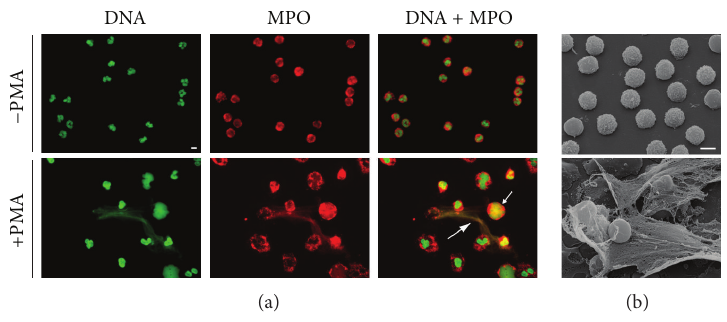
Figure 5: NET formation after PMA stimulation visualized by fluorescence (a) and scanning electron microscopy (b). Upper row shows unstimulated neutrophils; the lower row shows PMA stimulated neutrophils releasing NETs. The scale bar represents 10 𝜇 m (fluorescence microscopy) and 5 𝜇 m (scanning electron microscopy). (a) Immunohistochemical staining of neutrophils. Green: DNA staining with SYTOXgreen; red: MPO; overlay: SYTOXgreen and MPO. NET release of freshly isolated neutrophils was induced by 10 nM PMA and the samples were fixed after 3h. Arrows indicate NET fibres and NETotic cells, defined as NETs. (b) Scanning electron microscopy of NET formation induced by 20 nM PMA and fixed after 3.5